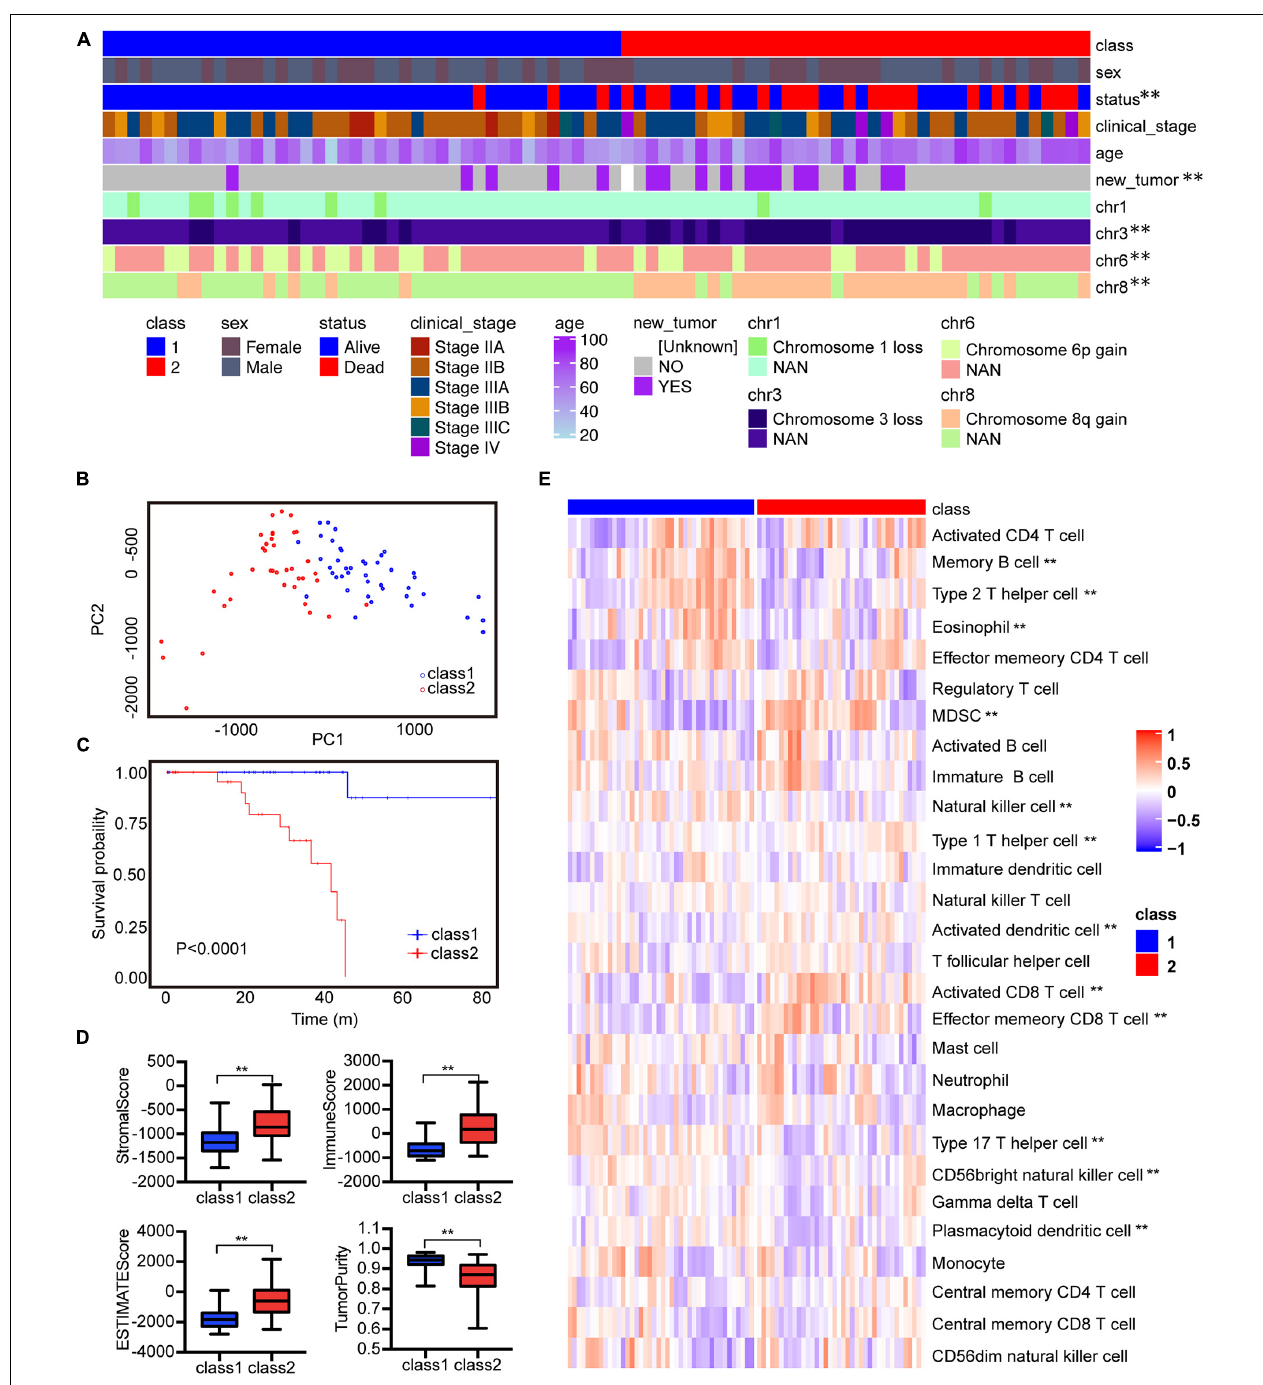
FIGURE 1 | The two immune subtypes show different clinical characteristics outcomes and tumor immune infiltrating characteristics in TCGA. (A) Clinical characteristics of two immune subtypes. (B) PCA of two immune subtypes using 782 genes in TCGA. (C) Kaplan–Meier analysis of two immune subtypes based on overall survival. (D) Comparison of stromal, immune, ESTIMATE scores, and tumor purity scores for different immune subtypes in TCGA using ESTIMATE R package. (E) Heatmap of GSVA signature scores in TCGA. ** P < 0.05.